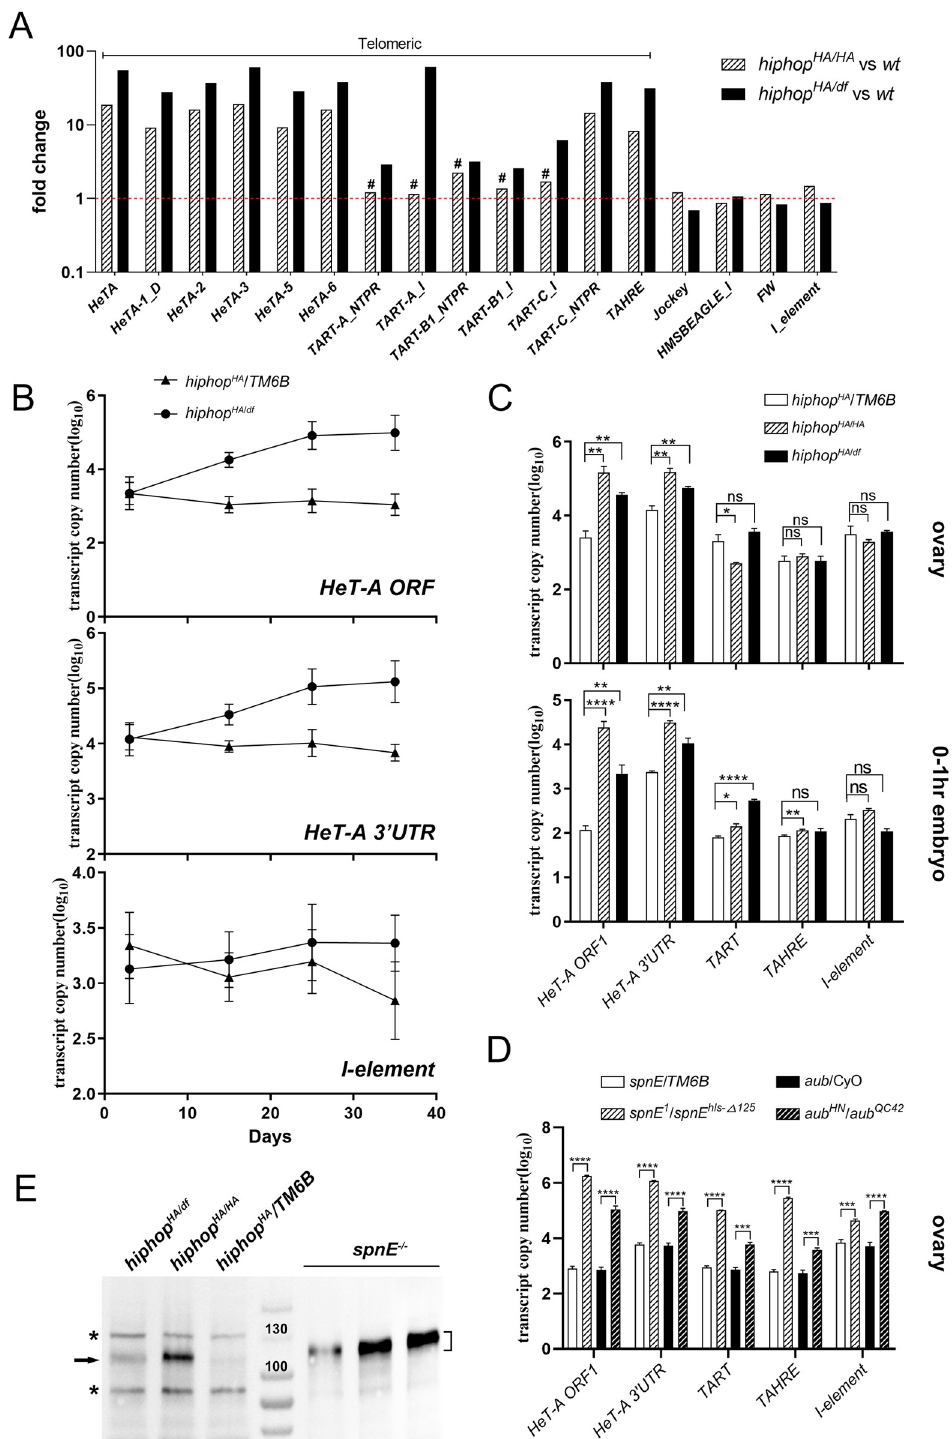
Fig 2. hiphop HA de-represses telomeric retrotransposons in the female germline. A . Fold changes between mutant and wildtype of all telomeric and four non-telomeric TEs are plotted for two genotype pairs. Except for the elements marked with # and under the hiphop HA background, telomeric TEs are significantly de-repressed in the mutants. Non- telomeric TEs do not show significant differences between the mutants and wildtype. Note that the Y axis is on a log 10 scale, and it is not drawn to scale. B . The effect of maternal age on TE de-repression in hiphop HA/df mutants.